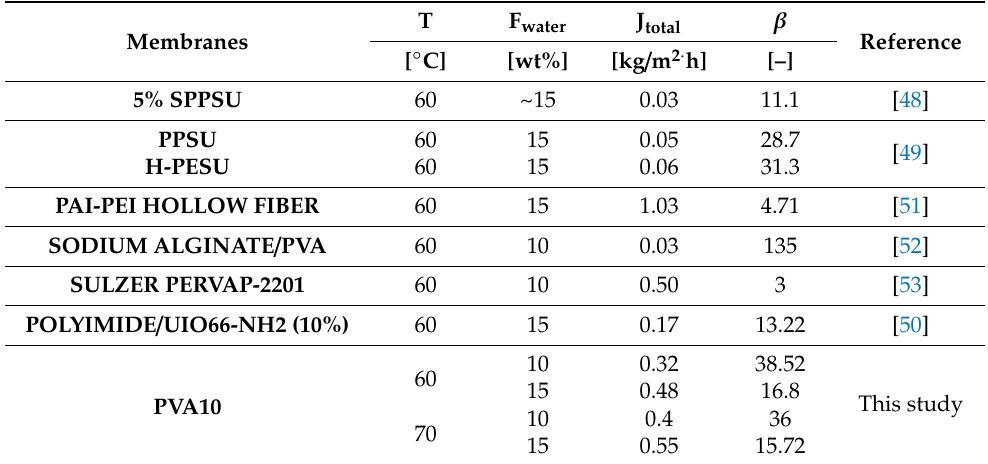
Table 2. Comparison of membranes for pervaporative dehydration of methanol-water mixture. Membranes